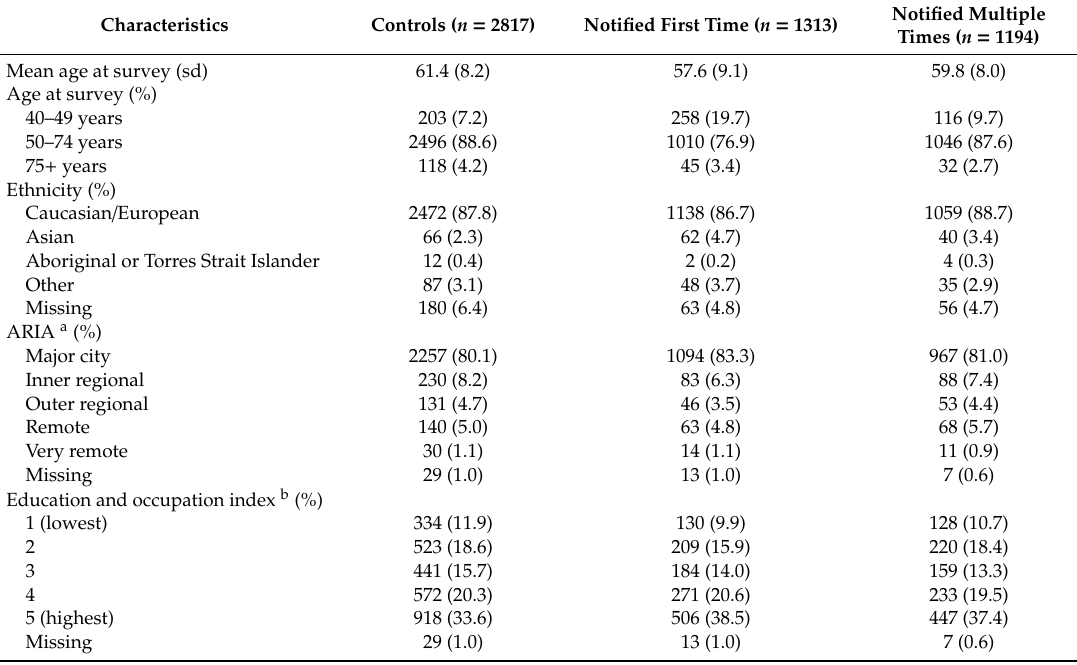
Table 1. Characteristics of respondents who were told they had dense breasts for first time ( n = 1313), multiple times ( n = 1194) and who have not been told ( n =